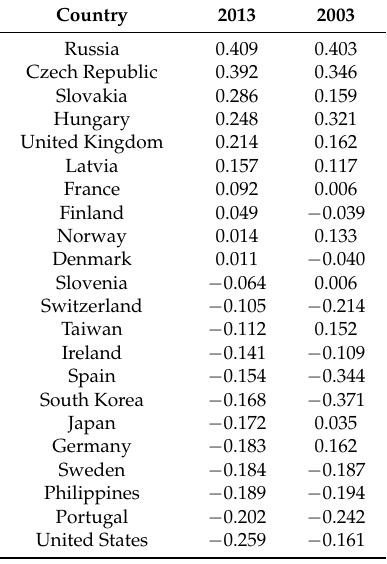
Table 1. Country means for perceived immigrant threat for 22 countries. ( n = 18,433 in 2013; n = 21,990 in